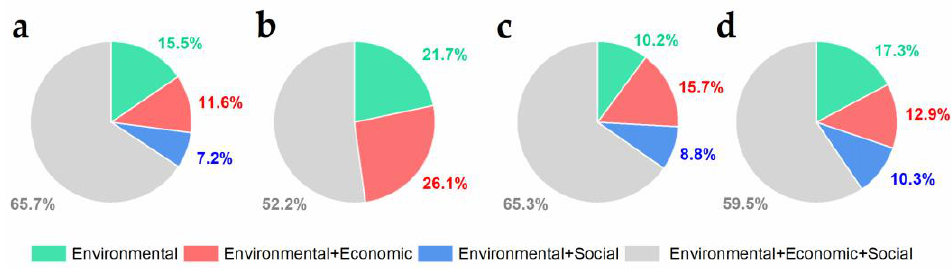
Figure 1. Share of individual answers to the surveyed groups: ( a ) investors, ( b ) architects, ( c ) contractors, ( d ) sellers of construction products.